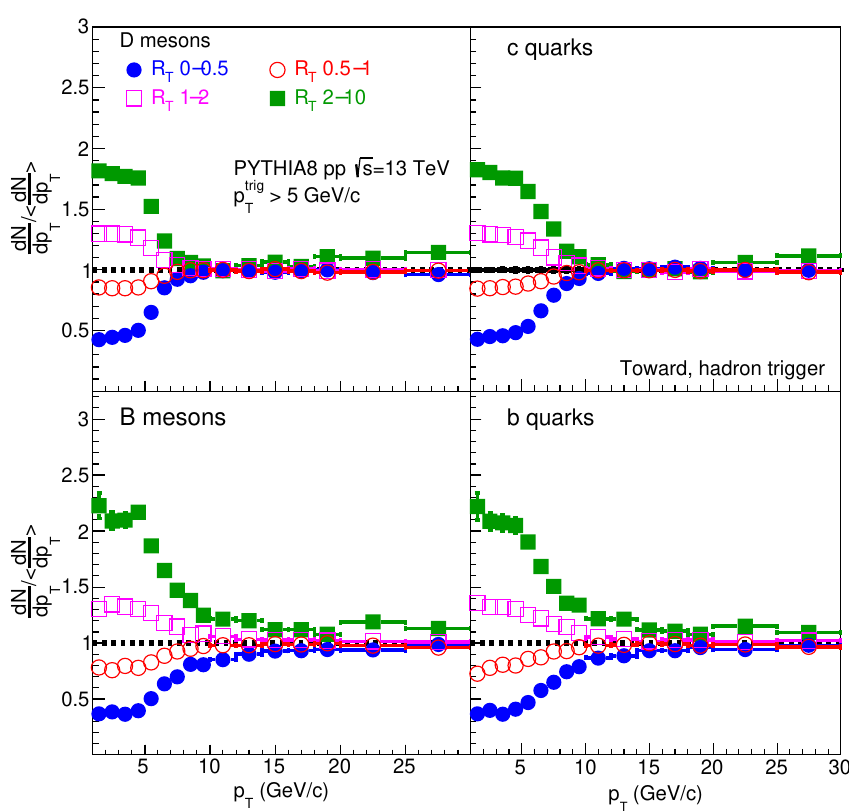
Figure 5. Per-trigger production ratios of D mesons ( top left ), c quarks ( top right ), B mesons ( bottom left ) and b quarks ( bottom right ) with charged-hadron triggers as a function of p T for different R T classes in the toward region, over the R T -integrated per-trigger